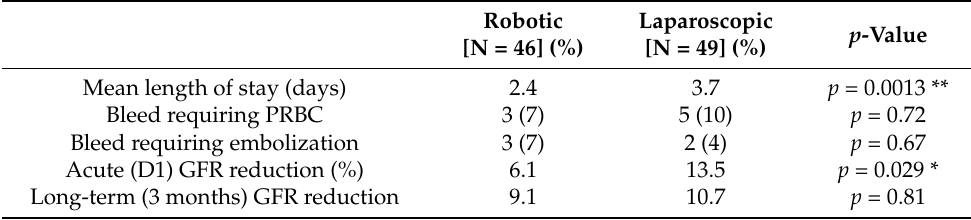
Table 4. Post-operative outcomes of robotic and laparoscopic partial nephrectomy cohorts. Robotic Laparoscopic p -Value [N = 46] (%) [N = 49] (%) Mean length of stay (days) 2.4 3.7 p = 0.0013 ** Bleed requiring PRBC 3 (7) 5 (10) p = 0.72 Bleed requiring embolization 3 (7) 2 (4) p = 0.67 Acute (D1) GFR reduction (%) 6.1 13.5 p = 0.029 * Long-term (3 months) GFR reduction 9.1 10.7 p =